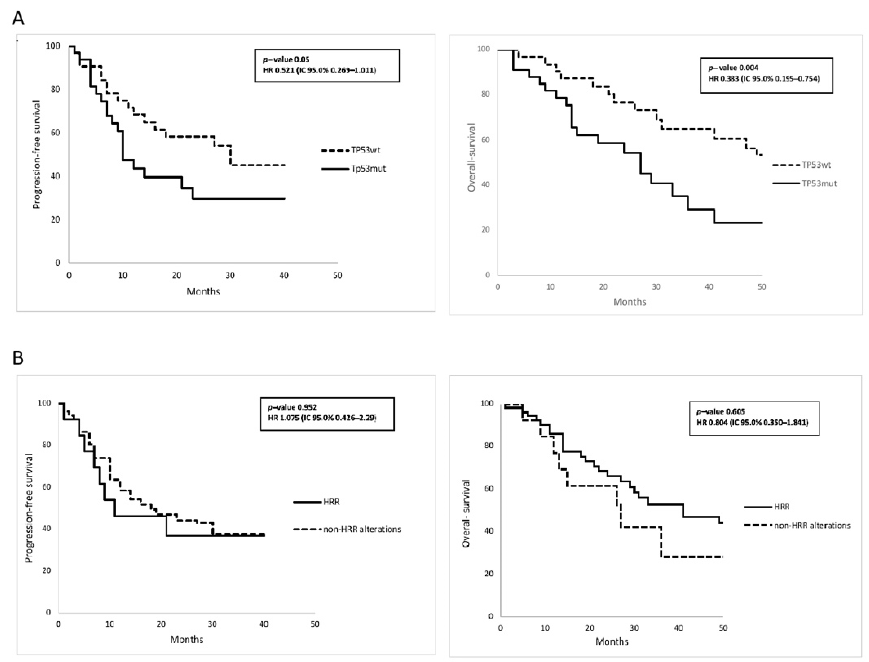
Figure 4. PFS and OS according to patients with: ( A ) wild-type TP53 versus mutated TP53; ( B ) HRR versus non-HRR alterations.